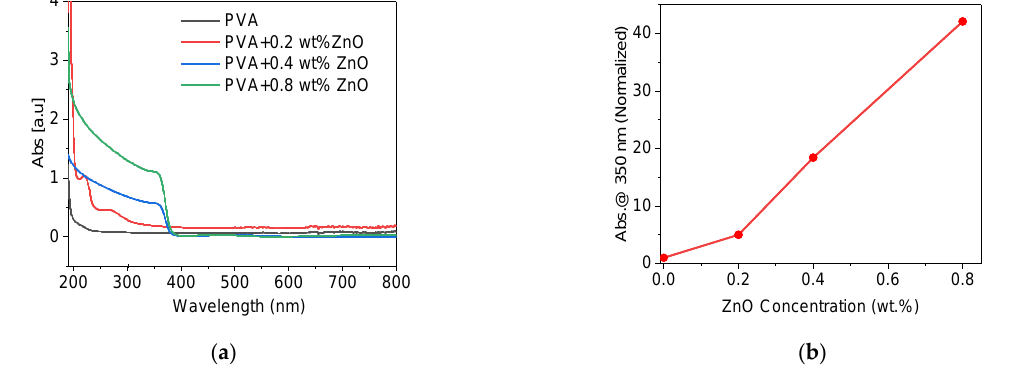
Figure 12. ( a ) UV – VIS (ultraviolet – visible) spectroscopy of thin films of ZnO/PVA (indicated by the black line), PVA (indicated by the red line), and ZnO nanoparticles (indicated by the blue line). ( b ) Normalized vs. ZnO concentration at 350 nm (black line) and 550 nm wavelength (red line).